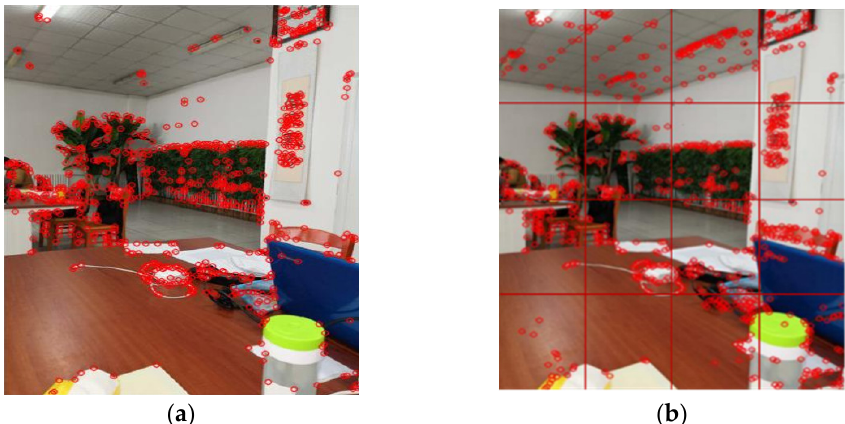
Figure 1. Comparison of feature extraction results: ( a ) non-gridded BRISK feature extraction; ( b ) gridded BRISK feature extraction.